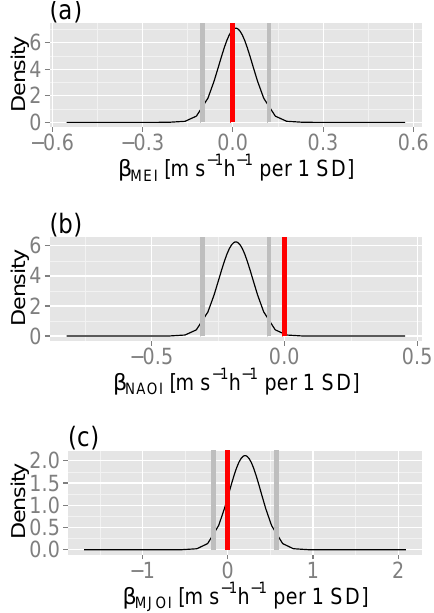
Figure 10. Posterior densities of the climate coefficients from the model. (a) β MEI , (b) β NAOI , and (c) β MJOI . Units are expressed as a change in intensification (ms − 1 h − 1 ) for a 1 standard deviation (SD) change in the covariate. The red line represents the x = 0 line (i.e., no effect). The gray lines represent the 95% CI.